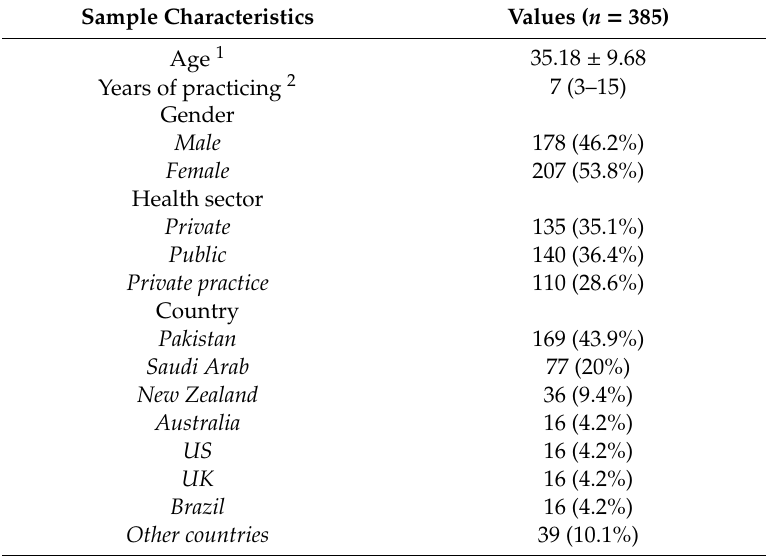
Table 1. Baseline information of study participants.